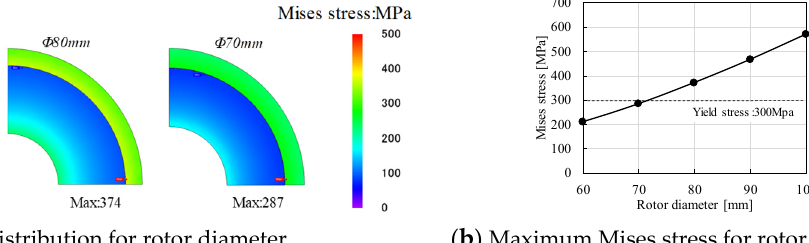
Figure 5. Mises stress of SPMSM at 52,000 min -1 .